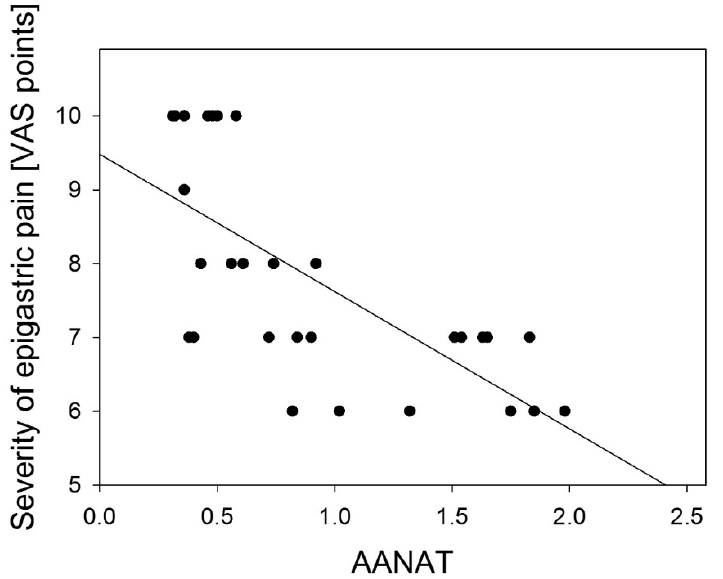
Figure 5. Correlation between arylalkylamine N-acetyltransferase (AANAT) expression assessed as relative quantity of mRNA of AANAT and hypoxanthine phosphoribosyltransferase (reference) by RT-PCR in body gastric mucosa and the severity of epigastric pain assessed by Visual Analog Scale (VAS) in patients with continuous epigastric pain syndrome ( n = 30). Regression line was calculated by means of the last square method, the R value was equal to − 0.697, p <